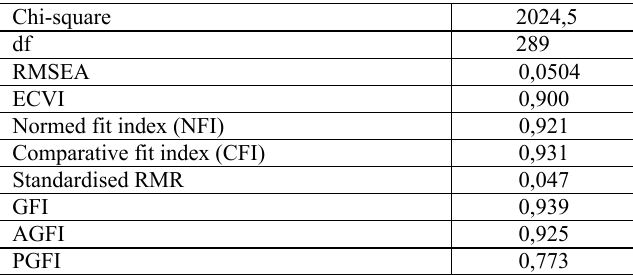
Table 4: Model fit indices